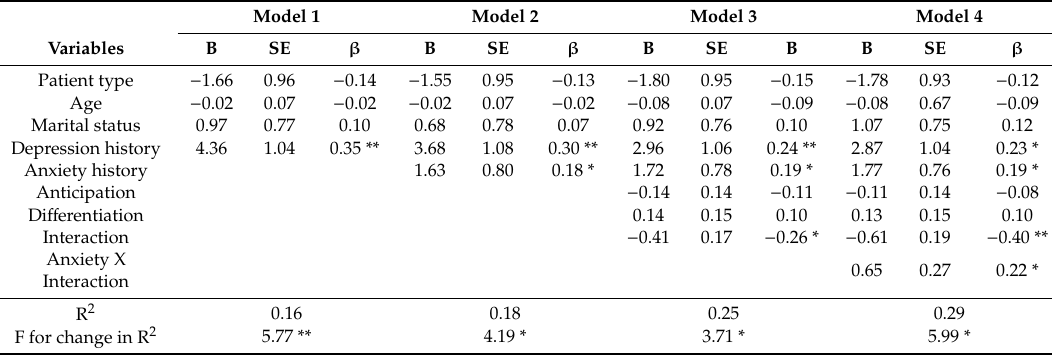
Table3. SummaryofthehierarchicalregressionanalysisforPatienttype, Age, Maritalstatus, Depression history, Anxiety history and Prenatal Attachment subscales predicting women’s depressive